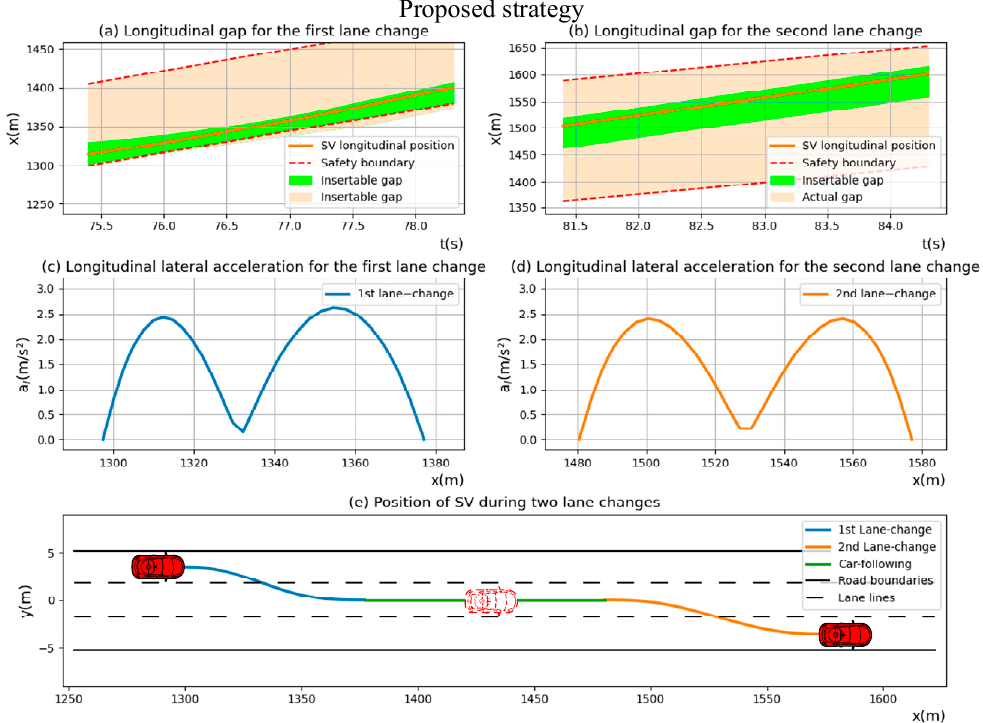
Figure 7. The position, lateral acceleration and trajectories of “Proposed strategy” during two lane-changing processes.